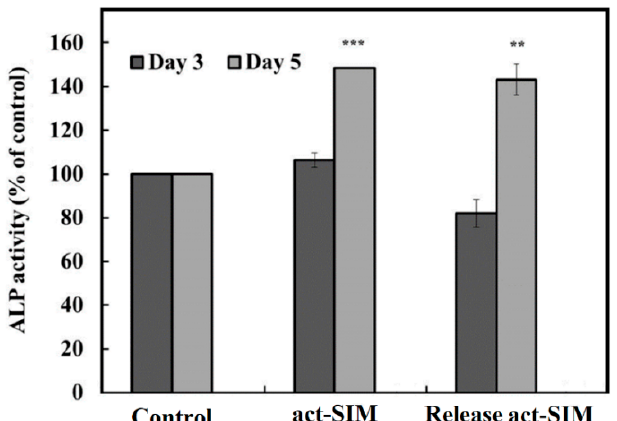
Figure 2. Alkaline phosphatase (ALP) activity evaluated in D1 cells. D1 cells were treated with 0.5 µ M active form of simvastatin (act-SIM) in bone medium or treated with 0.5 µ M act-SIM released from SIM-PP NPs loaded within bioceramic samples in bone medium for 5 days. The cells were further cultured in osteoinduction medium (OIM) for another 3 and 5 days. The control groups were not treated with act-SIM. Note: *** p < 0.001 and ** p < 0.01 com pare to day 5 Control.